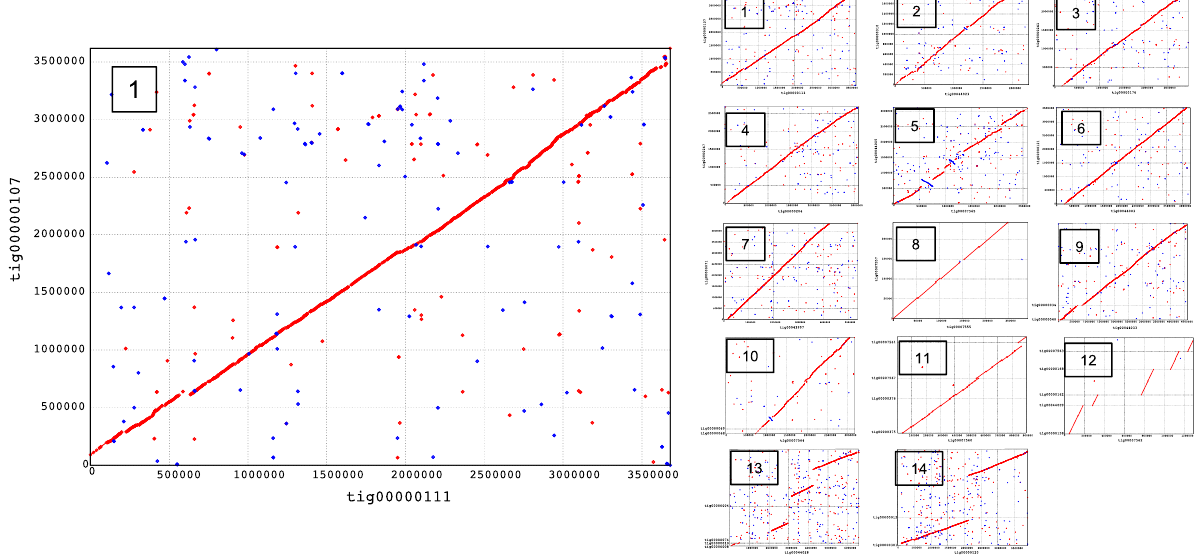
Figure 3. MUMmer dot plots of syntenic contigs in N. inconspicua diploid assembly. Enlarged view of pair #1 shows nucleotide positions for contigs along the x and y axes, with colored dots and lines indicating match direction (red = forward, blue = reverse). Full sized images for all 14 thumbnail views in are presented in Supplementary Figure S2. Assembly properties of paired contigs are described in Supplementary Table